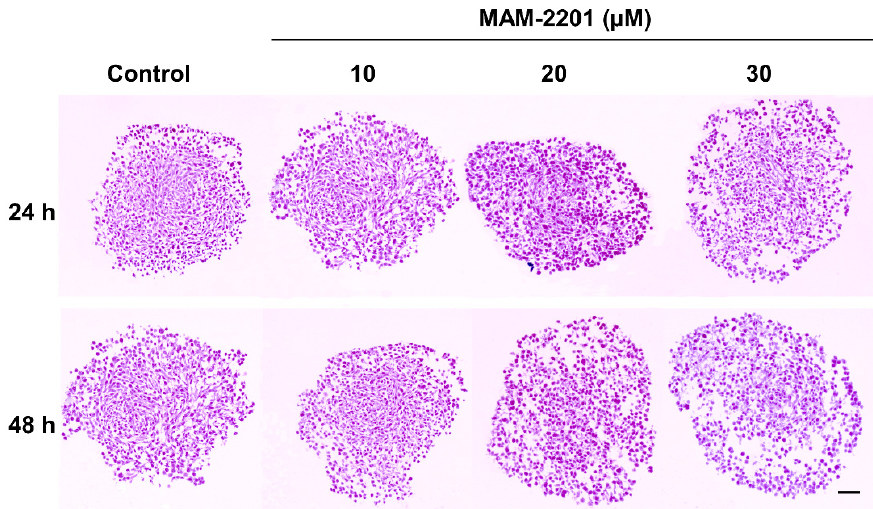
Figure 3. Spheroid histology. The cells were arranged close together and appeared densely packed at a starting density of 200 cells/well in the control spheroid samples at both 24 and 48 h. No necrotic core presence was observed in either the control or treated spheroids. In MAM-2201-treated spheroids, a loose cell packing and poor internal cohesion of cell-to-cell contacts were observed with an evident presence of interstitial spaces between individual cells. Scale bar: 100 µm.